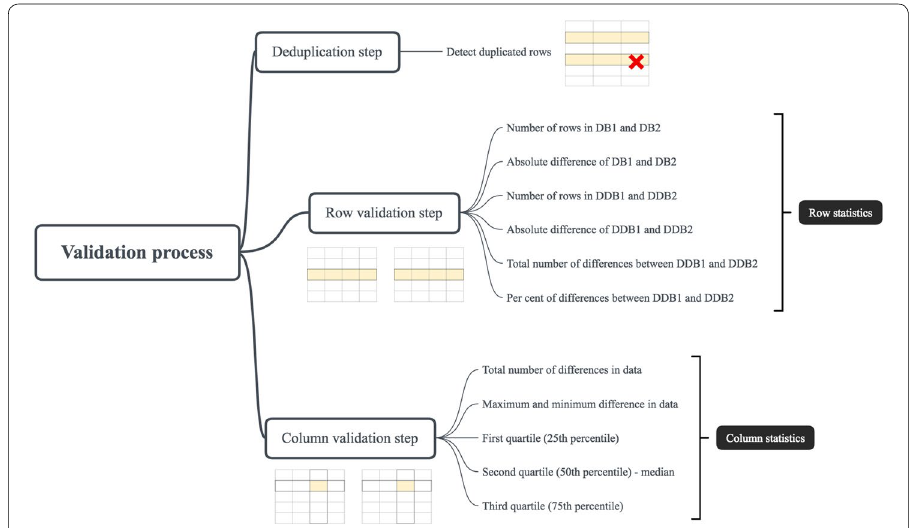
Fig. 3 High-level illustration of the validation